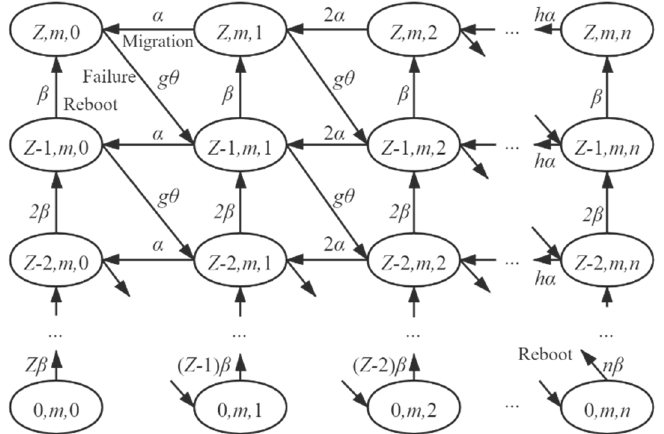
Figure 5. Transitions inside the blocks, triggered by failure (transitions toward bottom-right), mi- gration (leftward transitions), and reboot (upward transitions) of VM. 𝑛 = min(𝑥 (cid:2870) , 𝑍) . tion (leftward transitions), and reboot (upward transitions) of VM. n = min ( x 2 , Z )